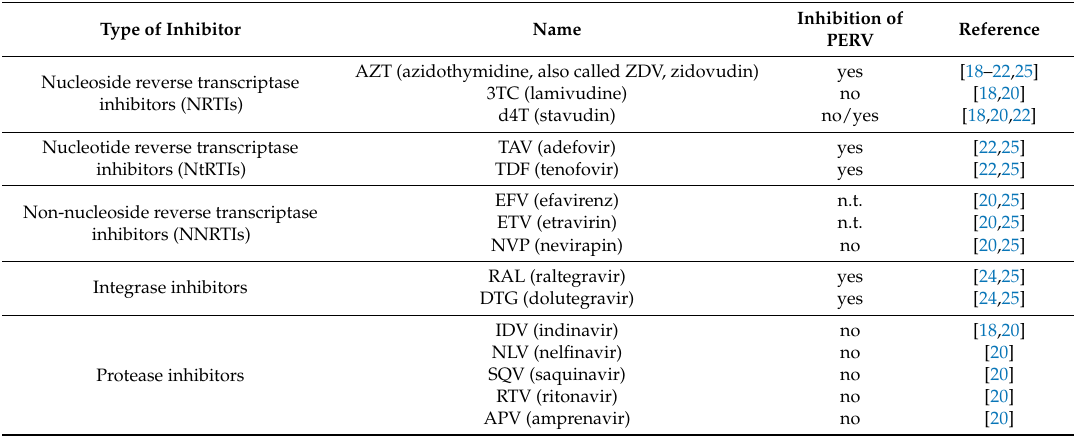
Table 1. Inhibitory activity of clinically used human immunodeficiency virus-1 (HIV-1) inhibitors on porcine endogenous retrovirus (PERV).